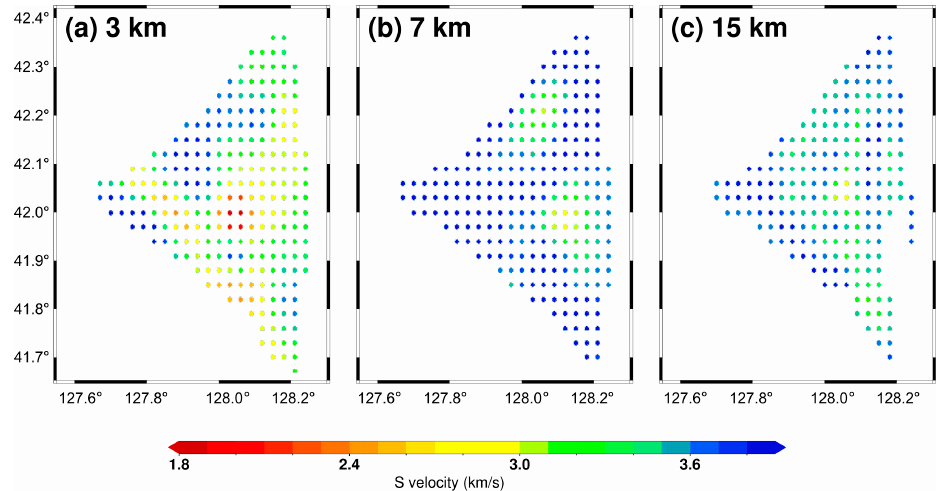
Figure A14. Combination of the interpolation and original results with 0.01° × 0.01° grid.